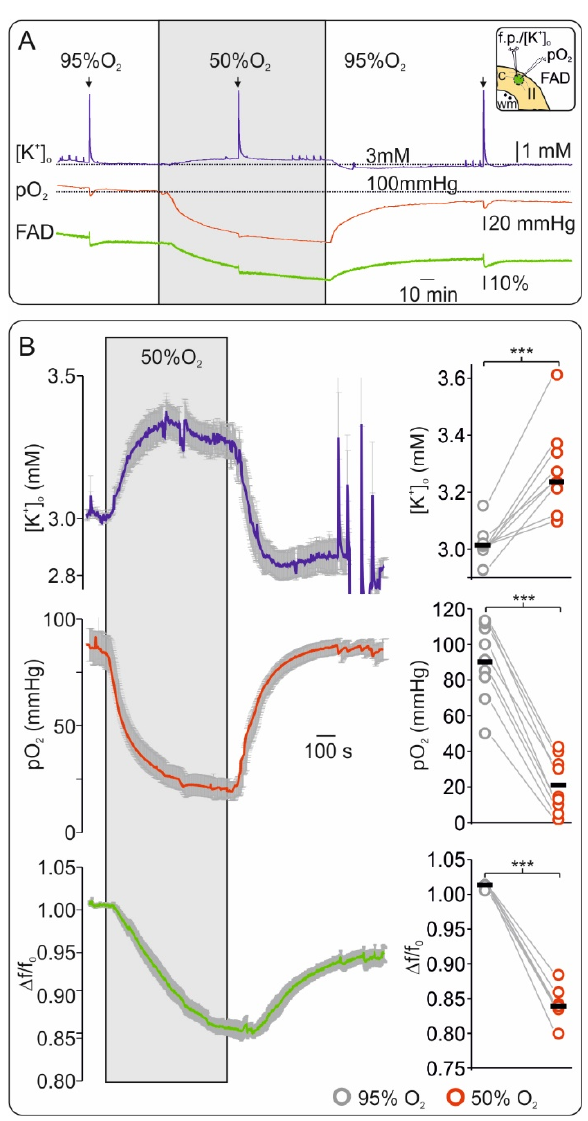
Figure 1. Flavin adenine dinucleotide (FAD) fluorescence is highly sensitive to short hypoxia in vitro. ( A ) Exemplary experiment of simultaneous recording of extracellular potassium ([K + ] o ) (upper trace blue), tissue oxygenation (pO 2 ) (middle trace, red) and FAD (bottom trace, green) showing the effects of short hypoxia (application of 50% oxygen, grey surface) and reoxygenation. Decreasing O 2 supply generated a slight increase in interstitial K + and a marked reductive shift of FAD fluorescence. Inflections in the traces resulted from electrical stimulation (arrows on top represent stimulation events of 20 Hz during 2 s, see Figure 2). Thus, the FAD signal was highly sensitive and timely coupled to changes in O 2 supply. Right on top: graphical representation of cortical slice detail and recording technic (c: neocortex, wm: white matter, II: layer II). Ion sensitive electrode and O 2 electrode were positioned in layer II of the frontal cortex in the area of interest for FAD imaging (green circle) while electrical stimulation was performed in the adjacent white matter (black dots). ( B ) Left: Average curves (with standard errors) for all experiments concerning changes in [K + ] o (top, blue line), pO 2 (middle, red line) and FAD (bottom, green line). Right: statistic plots of single values for each experiment (grey circles: control, red circles: hypoxia, black lines: median values). All parameters were recorded simultaneously, n = 9, *** = p < 0.001.